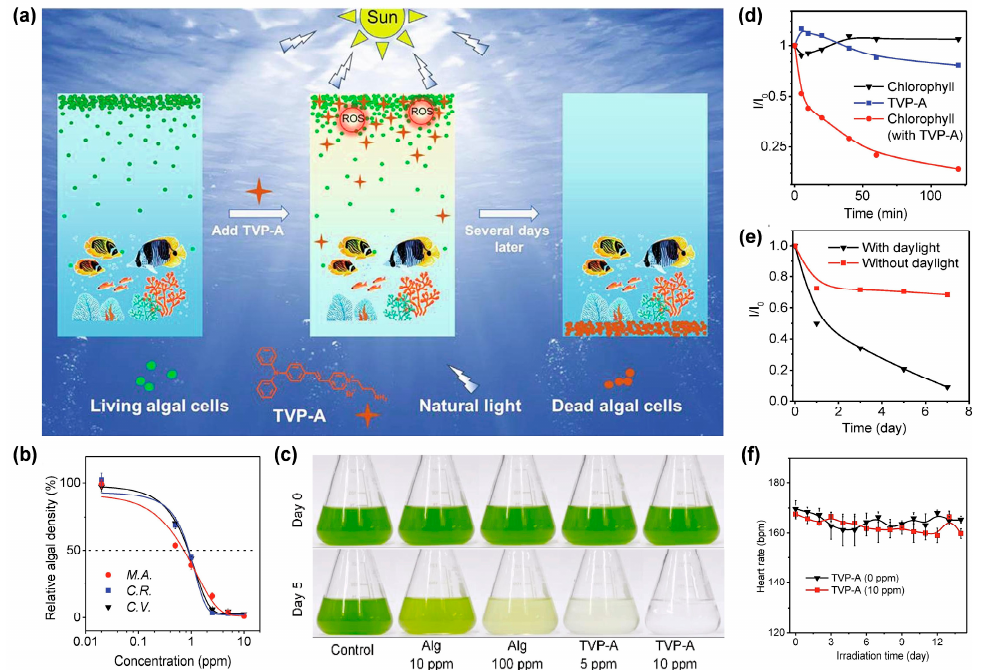
Figure 10. ( a ) Schematic illustration of selectively removing HAB by TVP-A upon natural light irra- diation. ( b ) Relative cell density of three algae after incubating with TVP-A at different concentrations after 96 h under the simulated daily cycles. M.A.: M. aeruginosa ; C.R.: C. reinhardtii ; C.V.: C. vulgaris . ( c ) Photos of C. reinhardtii (1.6 × 10 7 cells/mL) in the presence of Alg (10 ppm and 100 ppm) or TVP-A (5 ppm and 10 ppm) under the simulated daily cycles on day 0 and day 5. ( d ) The change of the relative fluorescence intensity ( I / I 0 ) in C. reinhardtii (1.6 × 10 7 cells/mL) in the presence or absence of TVP-A (5 ppm) under different times of simulated natural light illumination. ( e ) Varia- tion in relative absorbance of TVP-A at 462 nm with or without different natural light for evaluating the degradability of TVP-A. ( f ) The change of average heart rates of fish with or without TVP-A during the 14 days of cultivation time under the simulated daily cycles. Reprinted with permission from [82], copyright 2021, Elsevier.